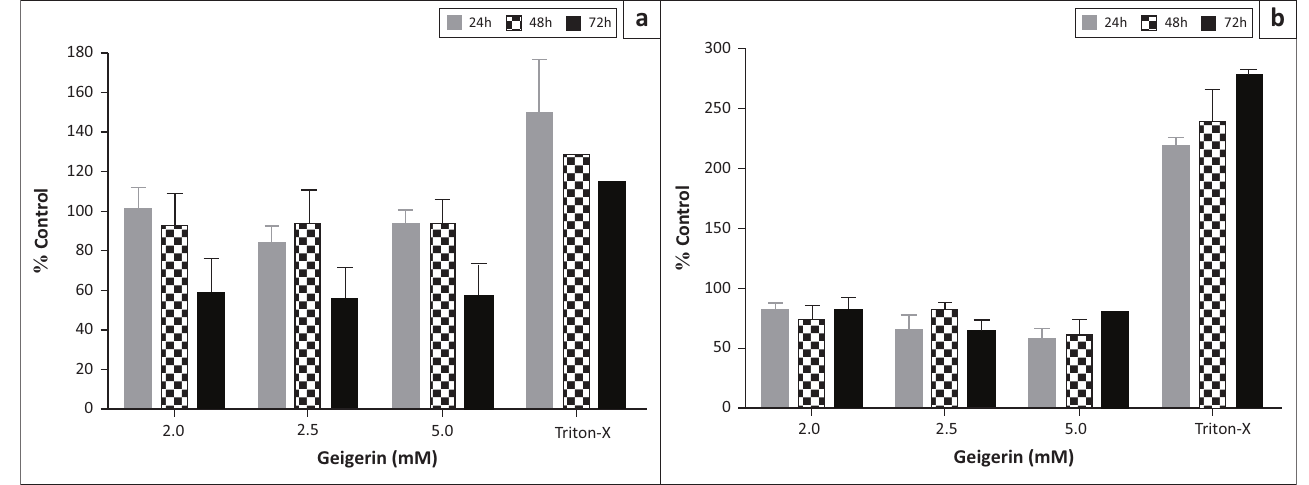
FIGURE 4: (a) Lactate dehydrogenase enzyme leakage and (b) propidium iodide uptake (flow cytometry), following exposure of C2C12 myoblasts to geigerin (2.0 mM, 2.5 mM and 5.0 mM), media only (control) and Triton-X (positive control) for 24, 48 and 72 h.